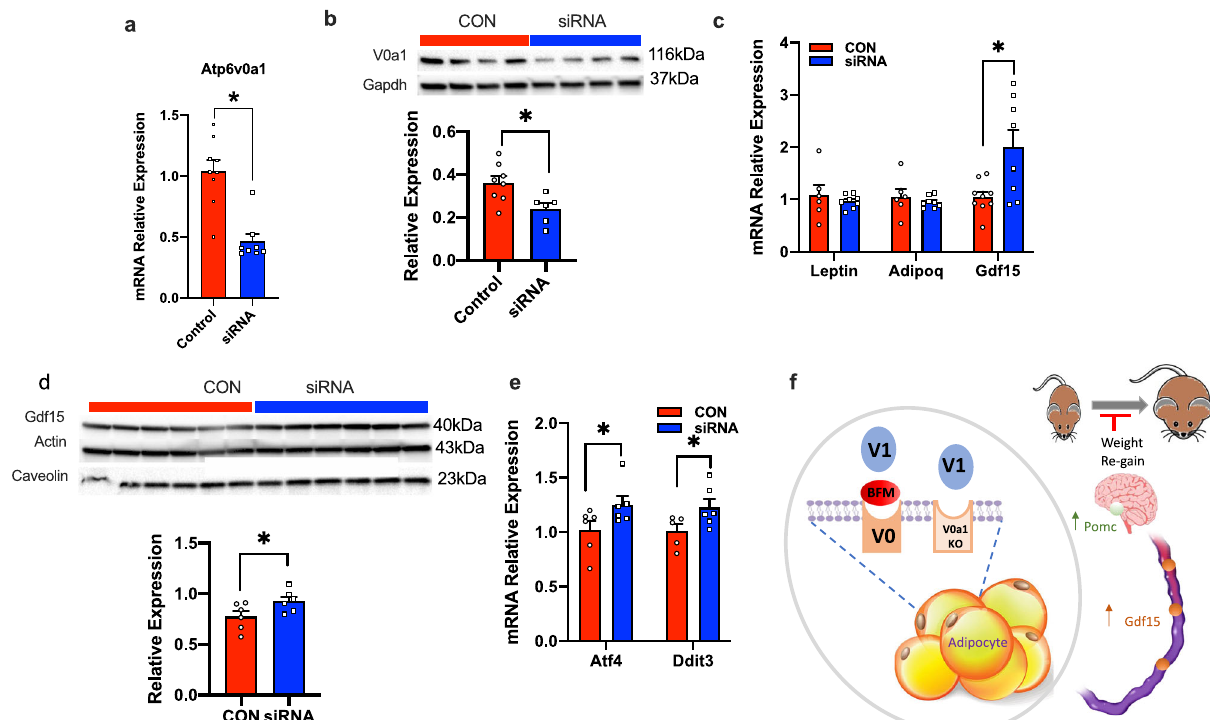
Fig.8|Adipocyte-speci fi cknockdownofAtp6v0a1increasesGdf-15expression in 3T3L1 adipocytes. a Relative Atp6v0a1 gene expression in 3T3-derived adipo- cytes treated with SiRNA targeting Atp6v0a1 (blue) or control siRNA (red) (control n =9, SiRNA n =8/group; t =5.10, df=15, p <0.001). b Western blots and densino- metric quanti fi cation of ATP6v0a1 (control, n =8, SiRNA n =6/group; t =2.78, df= 12, p =0.008). c Relative gene expression of leptin, adiponectin and Gdf-15 (Lep: t =0.67, df=12, p =0.51; Adipoq: t =0.76, df=12, p =0.46; Gdf15: t =2.86, df=12, p =0.01), control, n =6, SiRNA n =9/group. d Western blots and